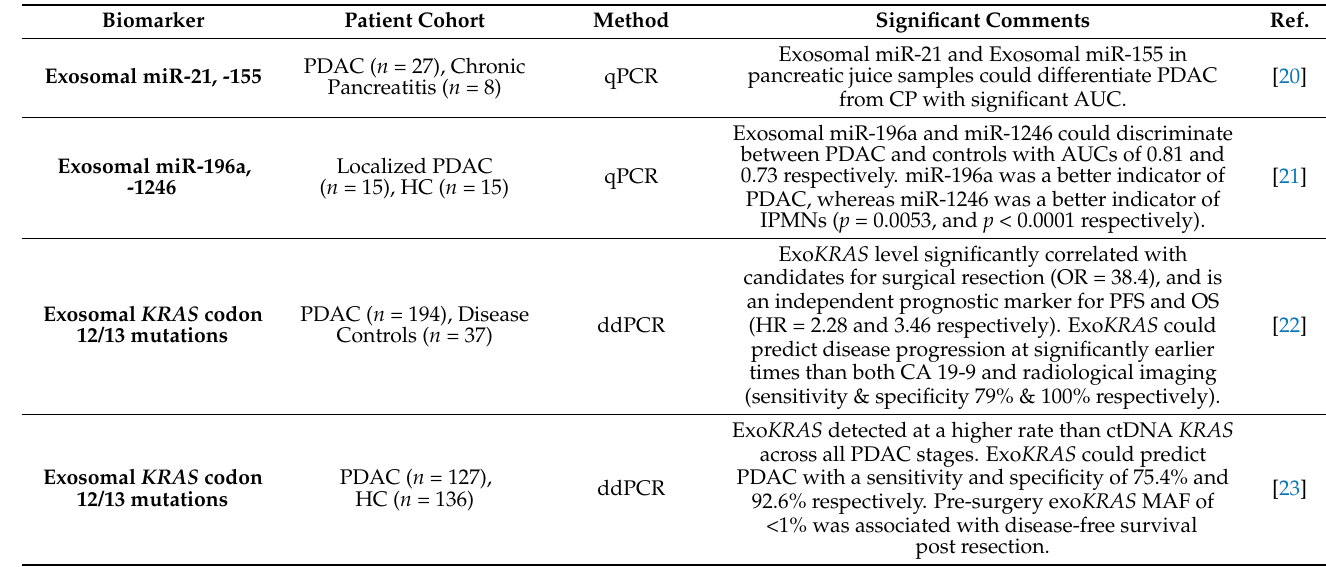
Table 1. Summary of Nucleic Acid Biomarkers for